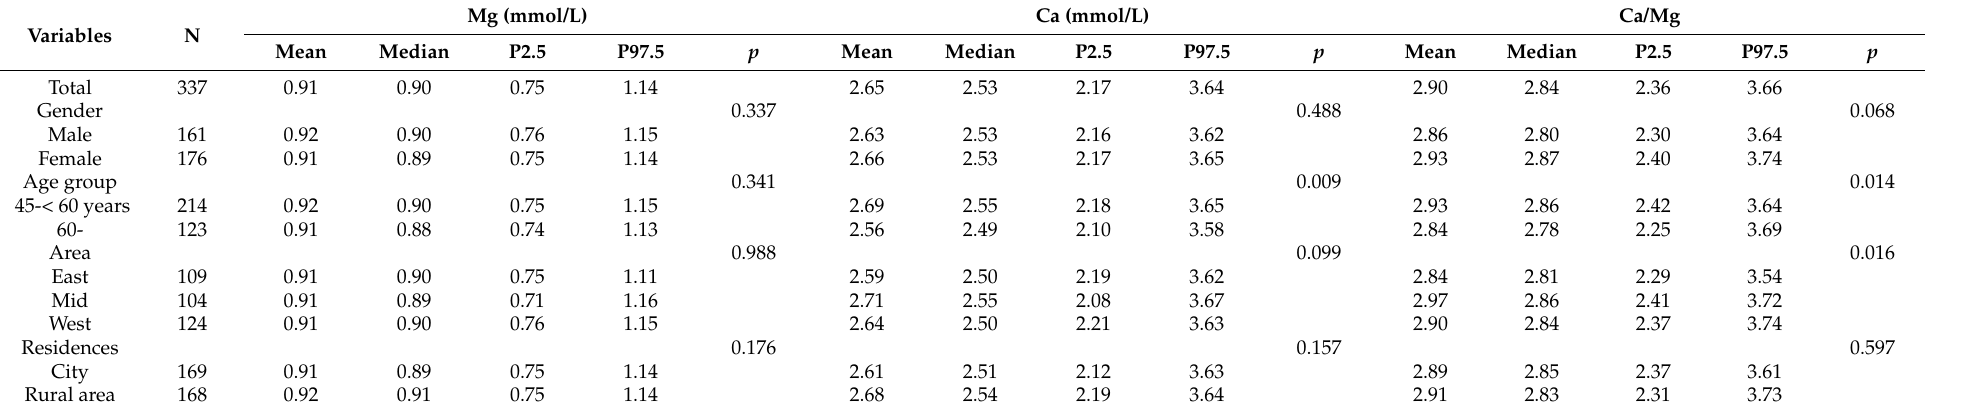
Table 2. Plasma concentrations of Mg, Ca, and Ca/Mg ratio in 337 healthy individuals (more than 45 years old).